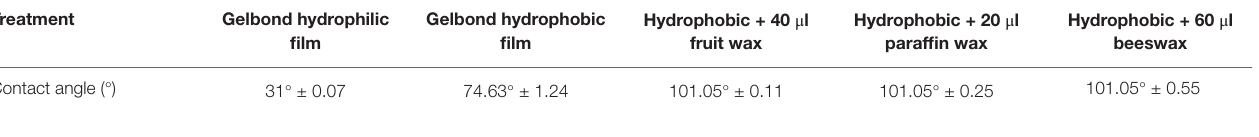
TABLE 1 | Hydrophobicity of the Gelbond hydrophobic